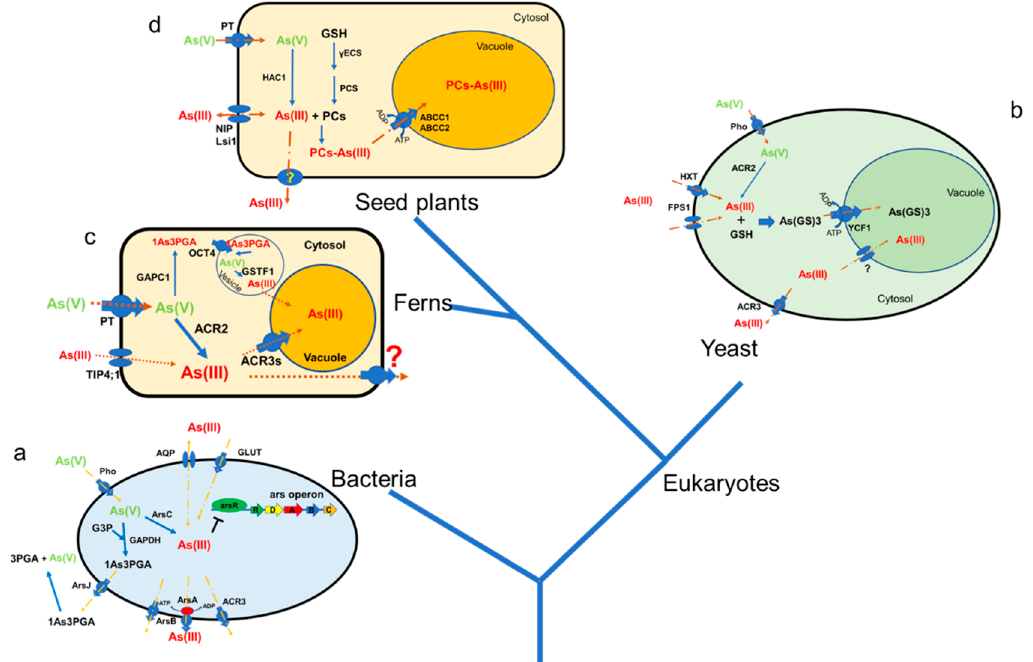
Figure 3. A simplified evolution scheme of arsenic resistance mechanisms mediated by As trans- porters in different organisms. ( a ). Arsenic resistance mechanisms in bacteria. As(V) enters bacteria cells via the phosphate uptake transporter (Pho) and is then reduced to As(III) by arsenate reductase ArsC. The bacteria cell detoxifies As(III) mainly by extruding it out by ArsB or ACR3 proteins. In some particular bacteria, As(V) can be transformed into 1-arseno-3-phosphoglycerate (1As3PGA) via glyceraldehyde 3-phosphate dehydrogenase (GAPDH). The 1As3PGA is then extruded by the ArsJ protein. ( b ) Arsenic tolerance mechanisms mediating As efflux and vacuolar sequestration in Saccharomyces cerevisiae . Arsenic enters yeast cells via FPS1 (fdp1 suppressor), HXTs (hexose trans- porter), and PHOs (phosphate transporter). Arsenate is reduced to As(III) by As(V) reductase ACR2, and cytosolic As(III) is extruded via ACR3 transporter or sequestrated into the vacuole by ScYCF1 after conjugation with glutathione. ( c ) Arsenic tolerance mechanisms in P. vittata . As(V), taken up by the phosphate transporter is reduced to As(III) by PvACR2, which is then translocated from the root to the frond. In both root and frond tissues, As(III) could be detoxified by sequestrating in the vacuole mediated by the PvACR3 transporter. Further, a bacterial-like mechanism for As(V) toler- ance was evolved in P. vittata , which involves three genes, PvGAPC1, PvOCT4, and PvGSTF1. ( d ) Arsenic tolerance mechanisms in higher plants. Here, phosphate transporters and aquaporins me- diate the uptake of As(V) and As(III), respectively. Inside the plant cell, As(V) is reduced to As(III) via the HAC1 protein. As(III) is then detoxified by sequestration into vacuole followed by conjuga- tion with phytochelatins (PCs) or by extruding out of the cell via aquaporins or some unknown transporter. The As resistance mechanisms in higher plants gradually evolved from prokaryotes.